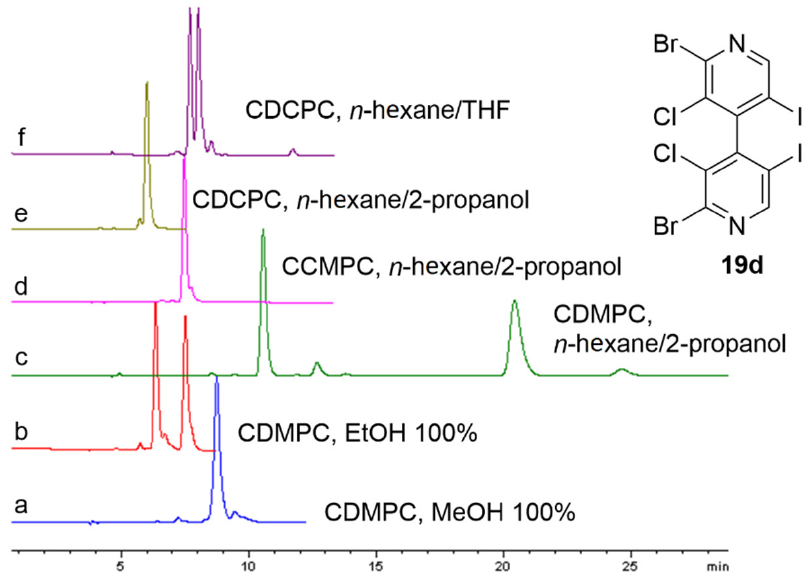
Figure 9. Solvent- and CSP-dependent chromatographic profiles of derivative 19d .